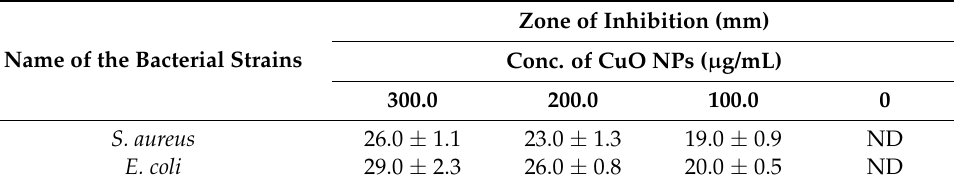
Table 2. Antibacterial efficacy of bio-reduced CuO NPs at different concentrations against S. aureus and E. coli by a zone of inhibition.